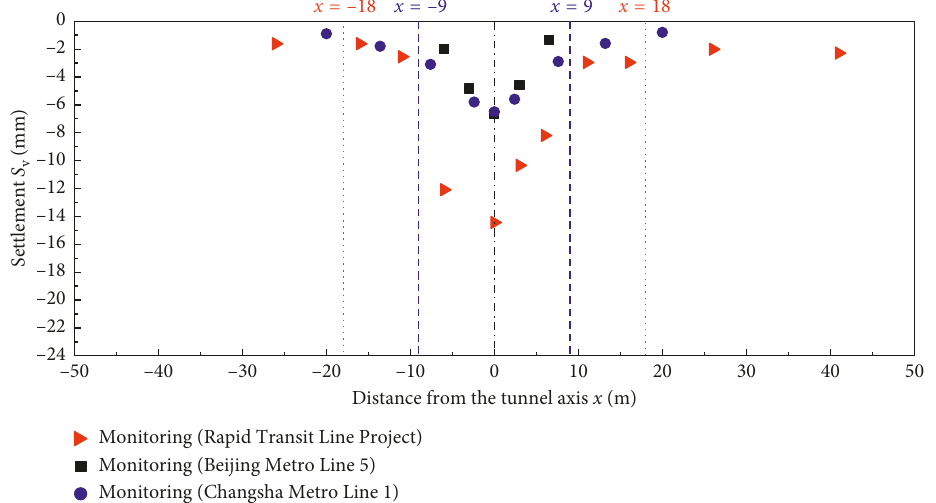
Figure 12: Monitoring transverse settlement profiles by the slurry shield with different diameters (Step 5).